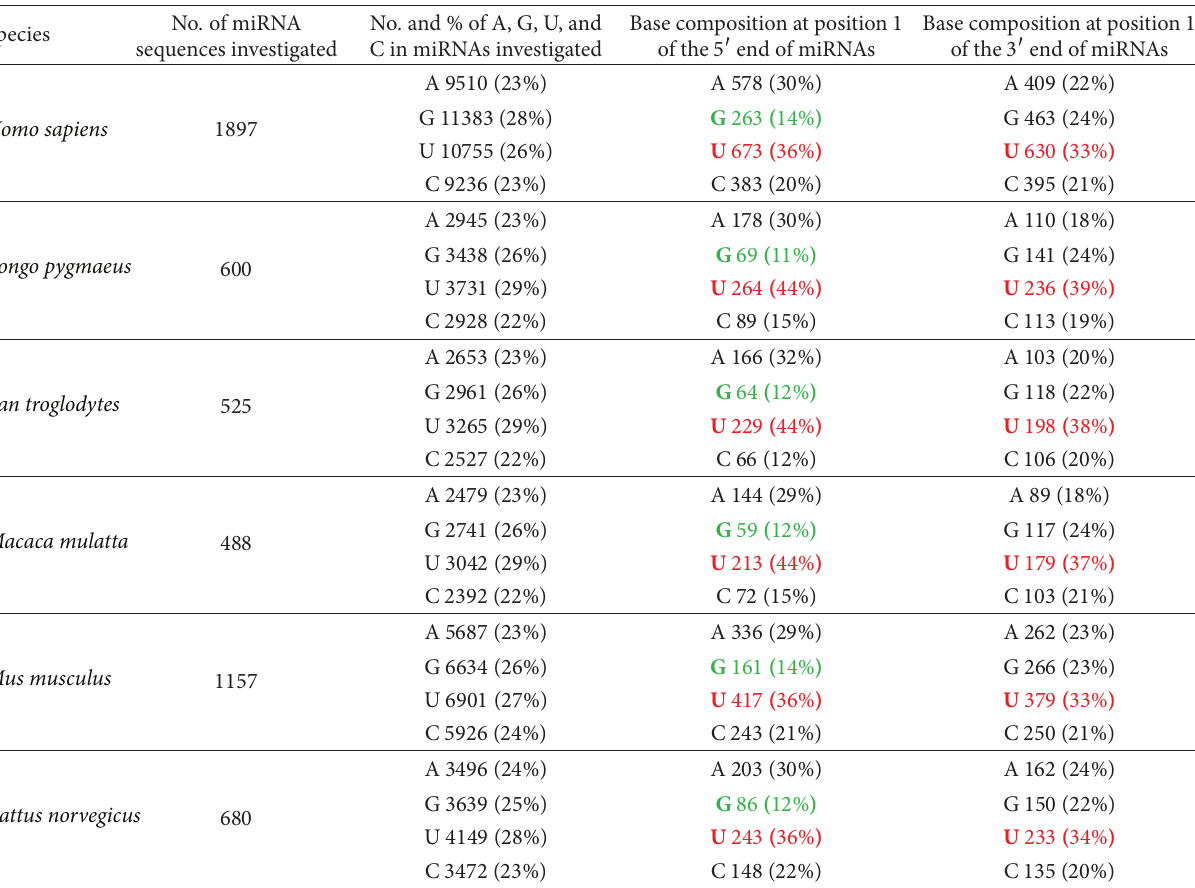
Table 1: Total base composition and base composition at position 1 of both ends of mature miRNAs in six mammalian species. Bases shown in red represent the most frequent residues in position 1 of both ends of the miRNAs, whereas bases in green indicate the least frequent residues in position 1 at the 5 󸀠 end of these